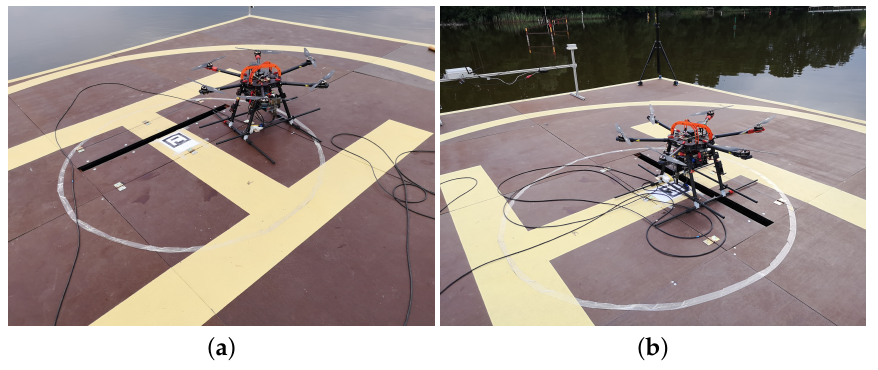
Figure 18. Tethered multicopter landing: ( a ) worst result—landing at a distance of 61 cm from the center of the landing pad; ( b ) best result—landing at a distance of 31 cm from the center of the landing